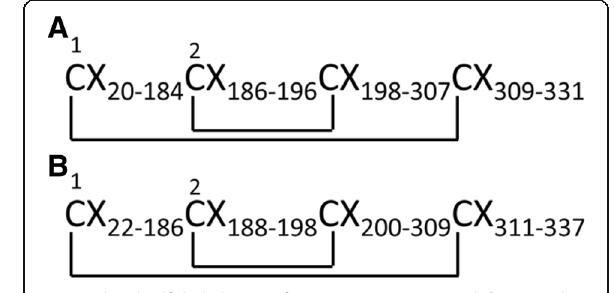
Fig. 6 The disulfide linkages of VesT2s [( a ); VesT2a and ( b ); VesT2b]. The two disulfide bridges (VesT2a; C 19 -C 308 and C 185 -C 197 , VesT2b; C 21 -C 310 and C 187 -C 199 ) are linked via a solid